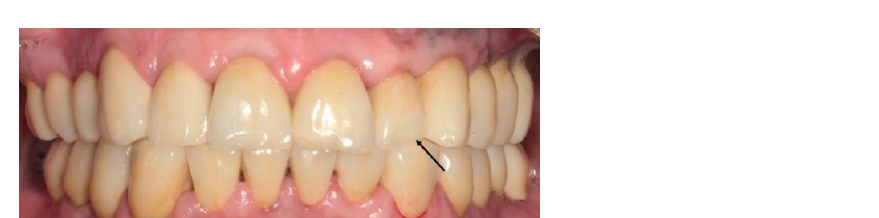
Table 5. Absolute (survival) and relative (complications) failures in the veneered and non-veneered zirconia groups.